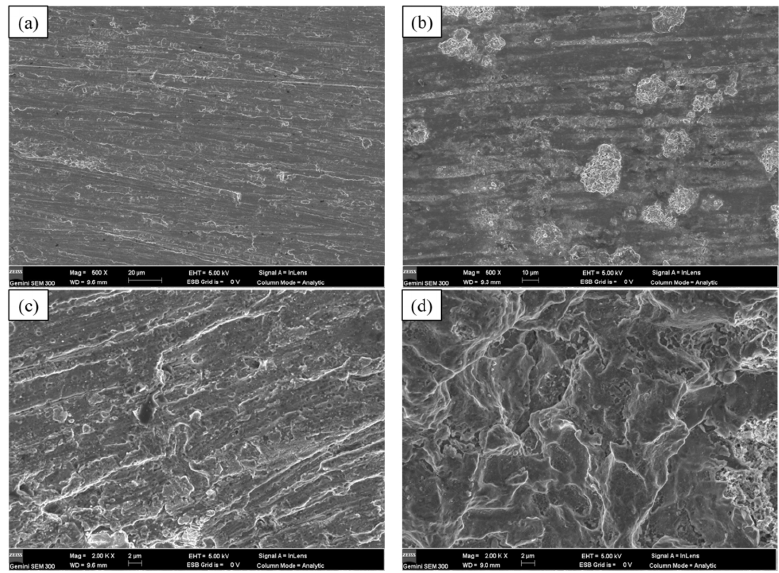
Figure 3. SEM morphology of specimen surfaces at different scanning speeds. ( a ) unCWJP, ( b ) 1.0_CWJP, ( c ) 0.5_CWJP, ( d )